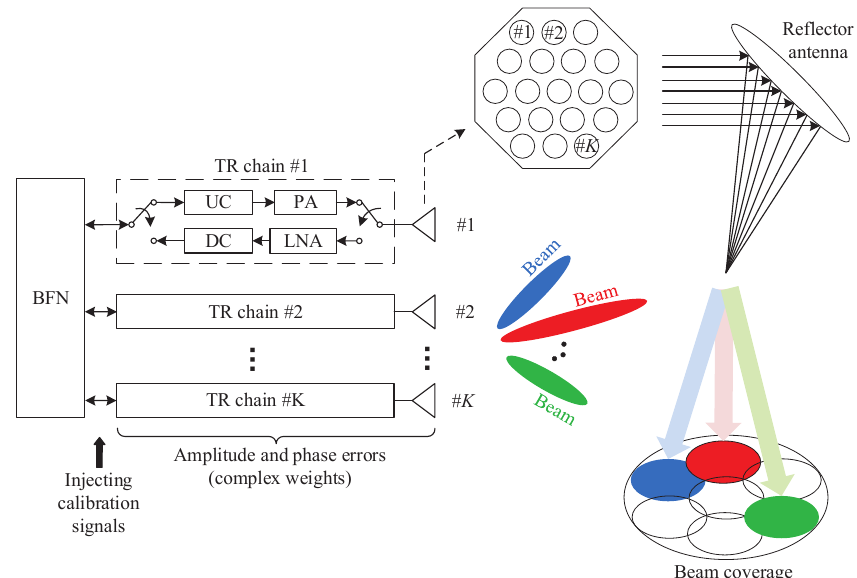
Figure 1. Online calibration model for multi-beam